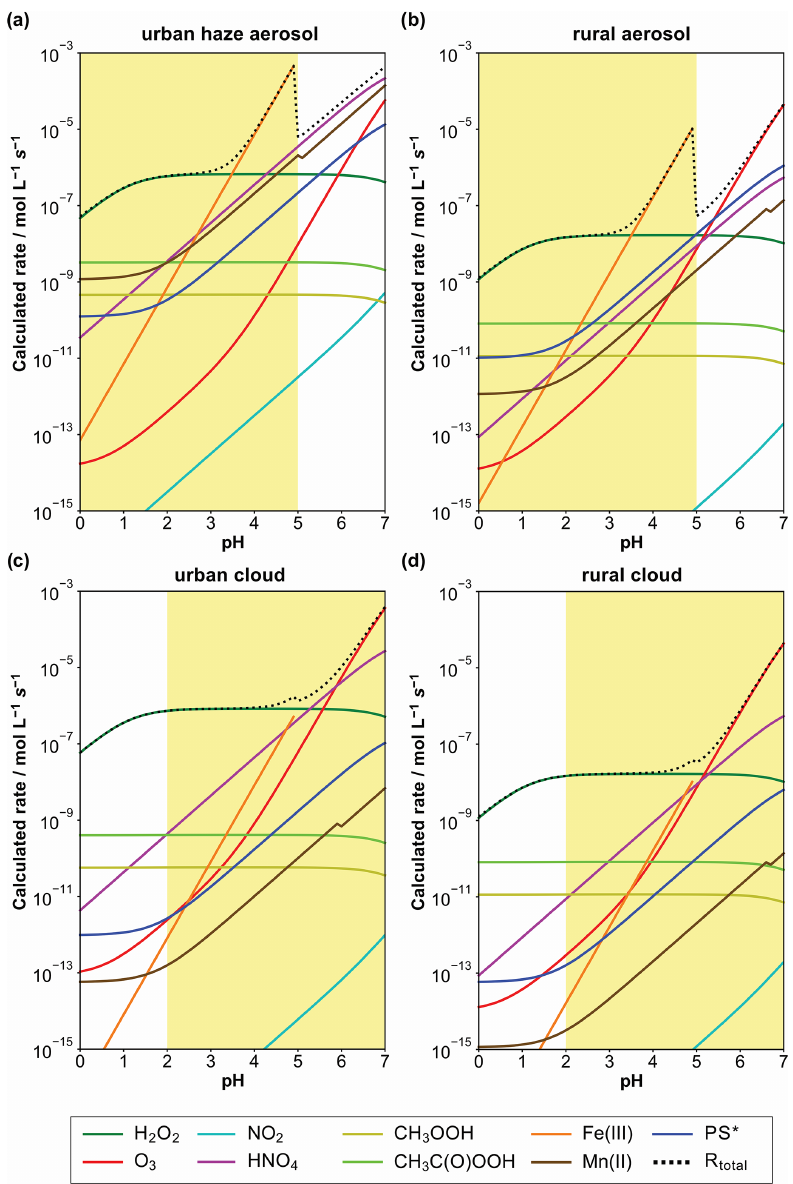
Figure 7. Calculated S(IV) oxidation rates of different reaction pathways in molL − 1 s − 1 for urban winter haze (a) and rural aerosol (b) conditions, as well as urban (c) and rural (d) cloud conditions at 298K. Applied conditions are given in Table 1, and the rate expressions used were those given in this text. The atmospherically relevant acidity range in the different cases is marked in